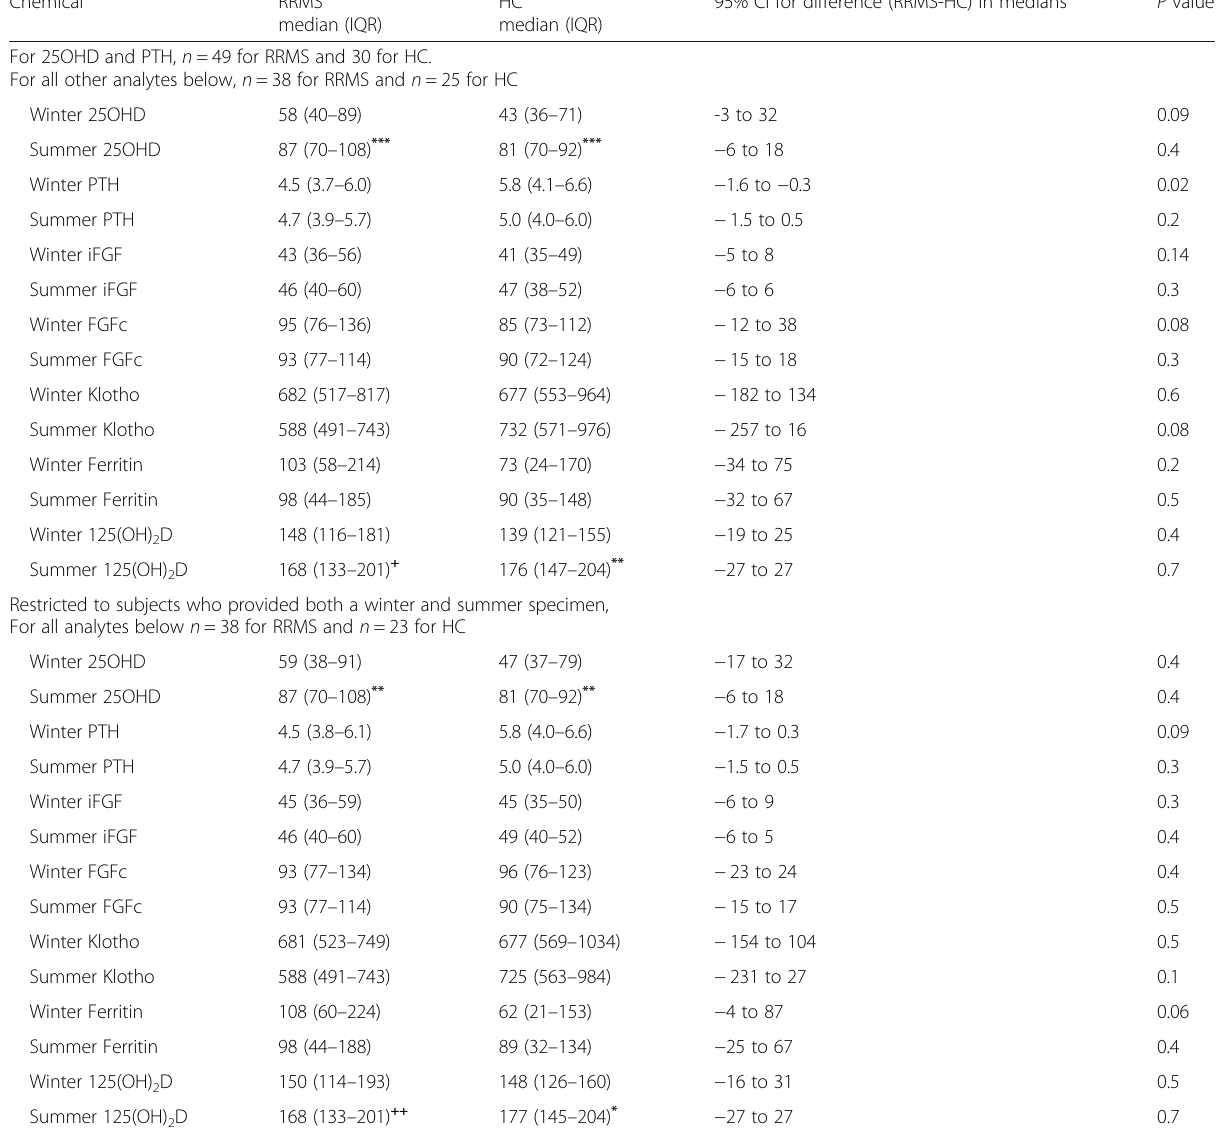
Table 1 Cohort analyses